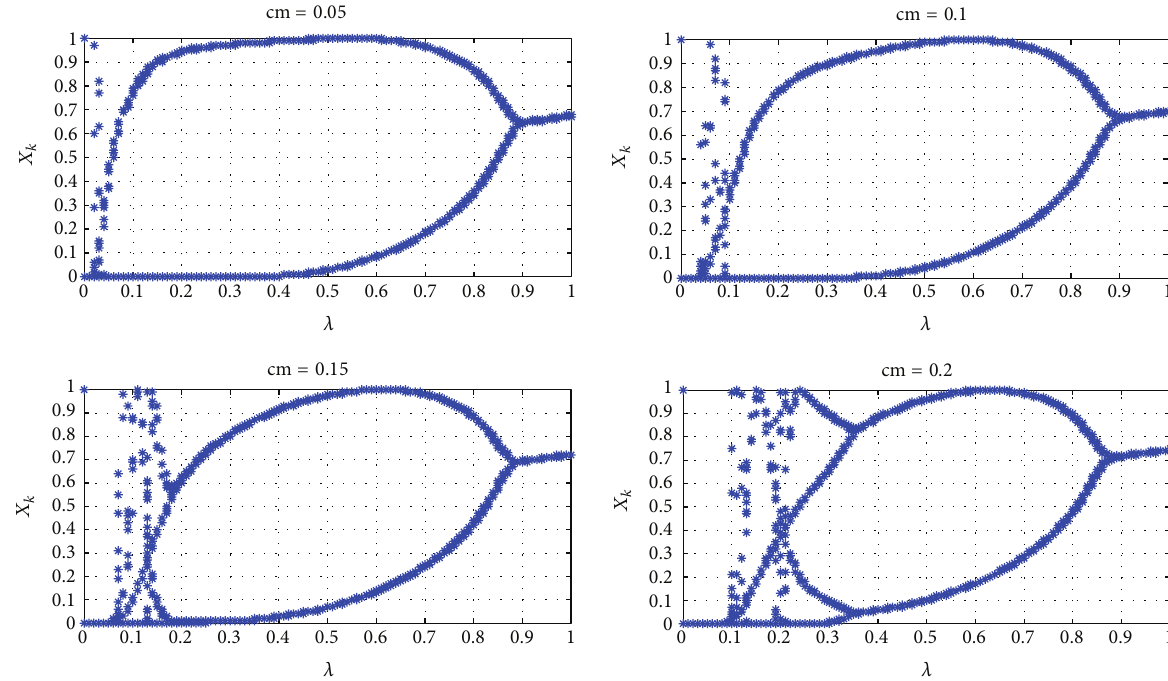
Figure 10: Bifurcation diagram using cm = 0.05 , 0.10, 0.15, and